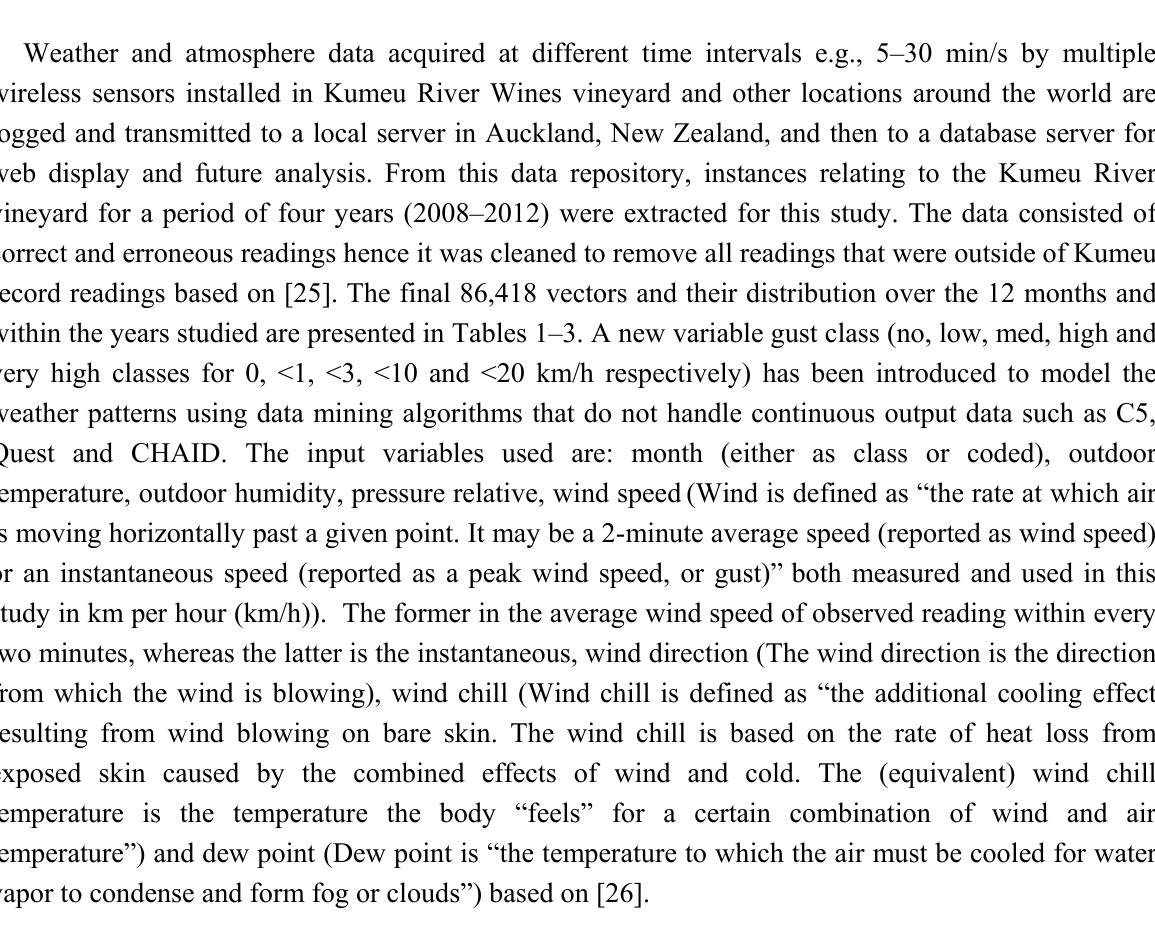
1. Distribution of Kumeu meteorological data over different